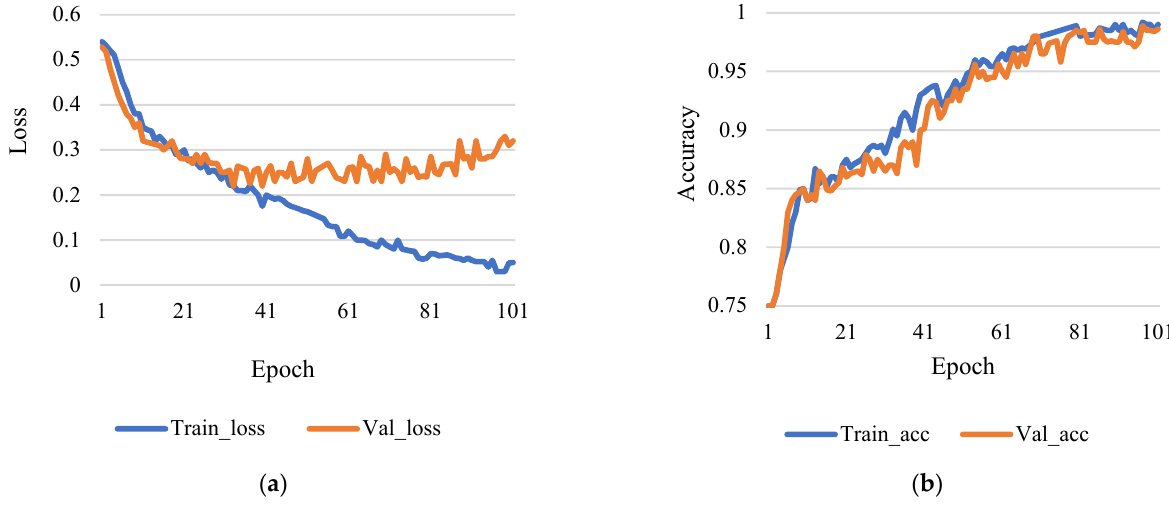
Figure 7. ( a ) Training loss vs validation loss (rate of learning 0.001 and epoch 100). ( b ) Training accuracy vs validation accuracy (rate of learning 0.001 and epoch 100).